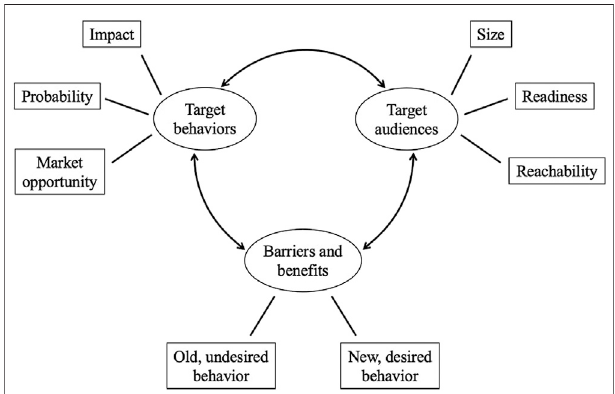
FIGURE 1 | Key elements to consider designing a behavior change intervention (adapted from Campbell and Brauer,